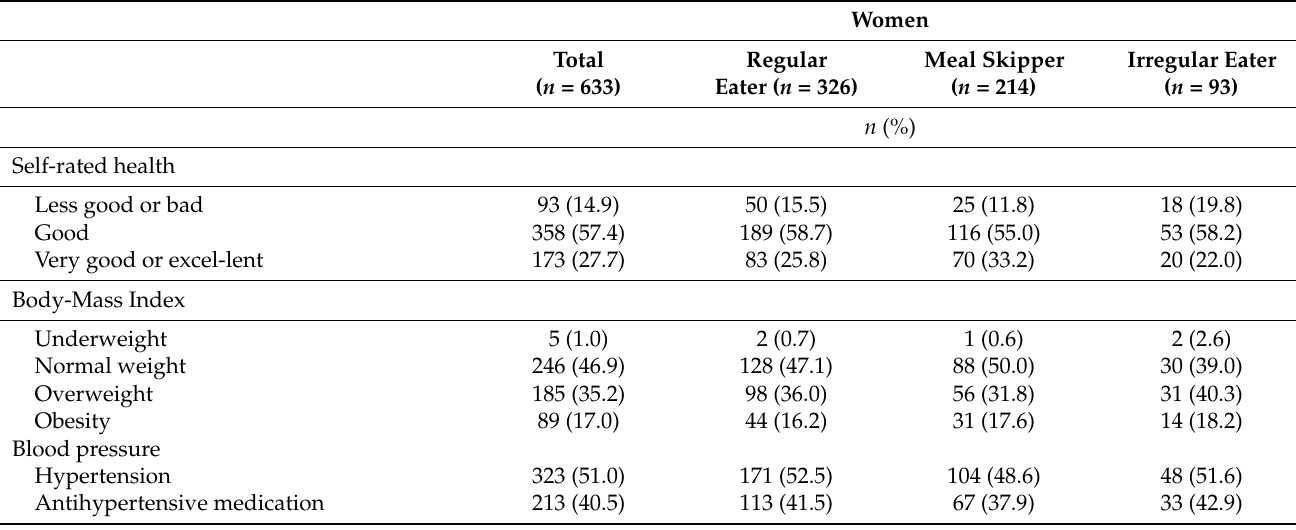
Table 3. Health indicators by meal pattern and